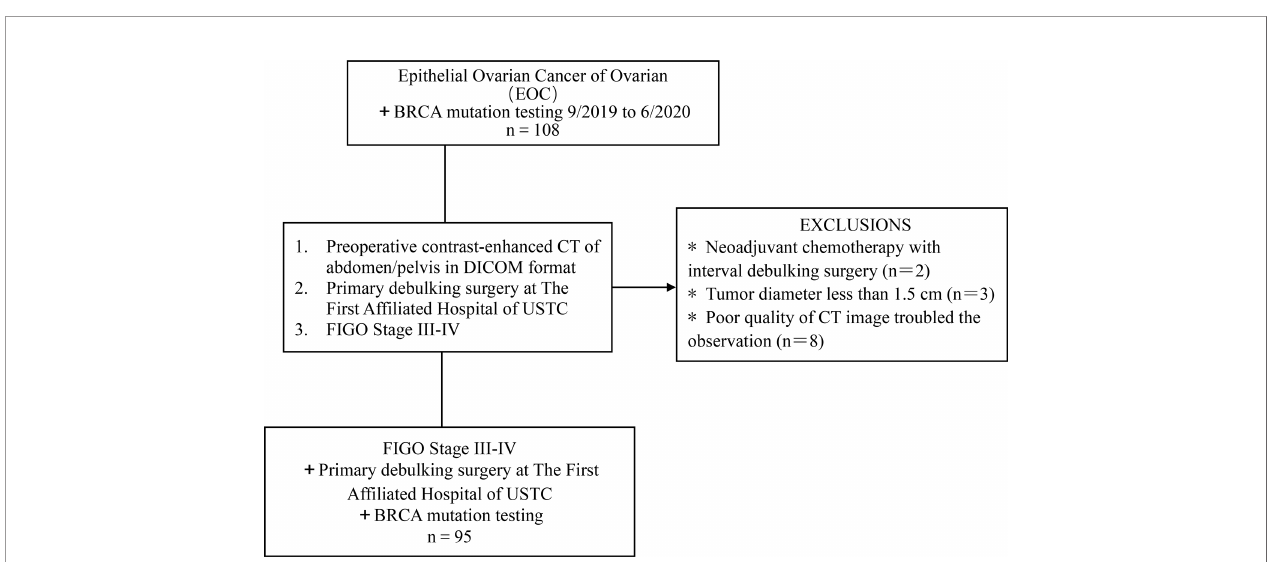
FIGURE 1 | Flowchart shows the details of patient selection process. DICOM, Digital Imaging and Communications in Medicine, FIGO, International Federation of Gynecology and Obstetrics; USTC, University of Science and Technology of